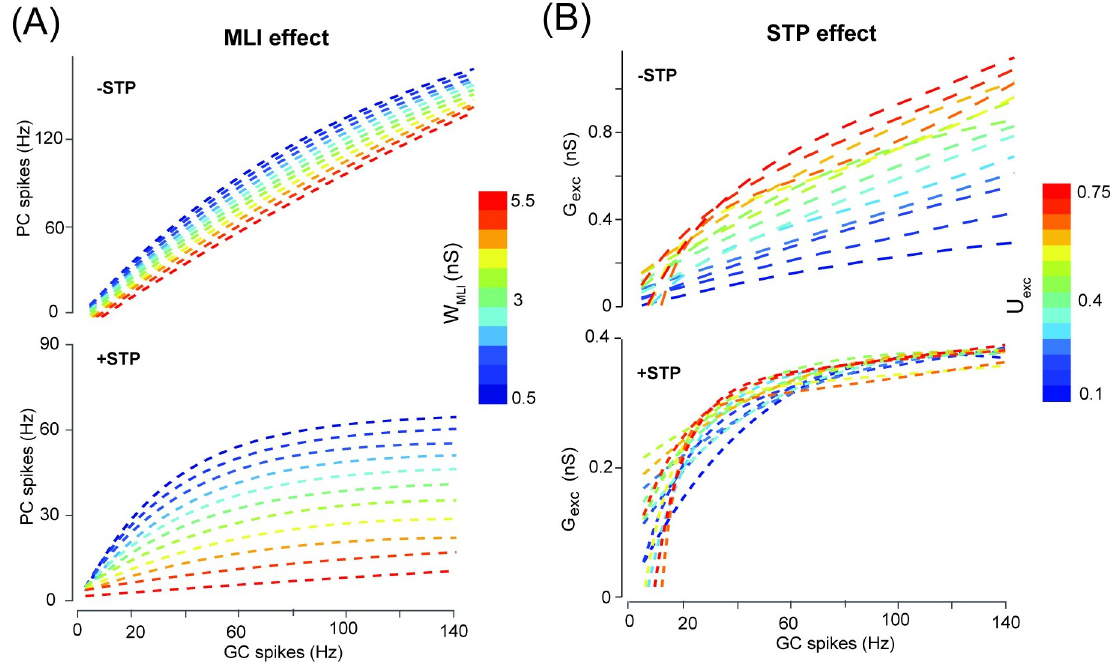
Fig 3. The gain change of PC firing significantly depending on GC-PC STP. (A) PC firing modulated by different levels of MLI inhibition strength without STP (top) and with STP (bottom) at U exc = 0.4. (B) Excitatory conductance modulated by different levels of GC-PC synaptic efficacy U exc without STP (top) and with STP (bottom).